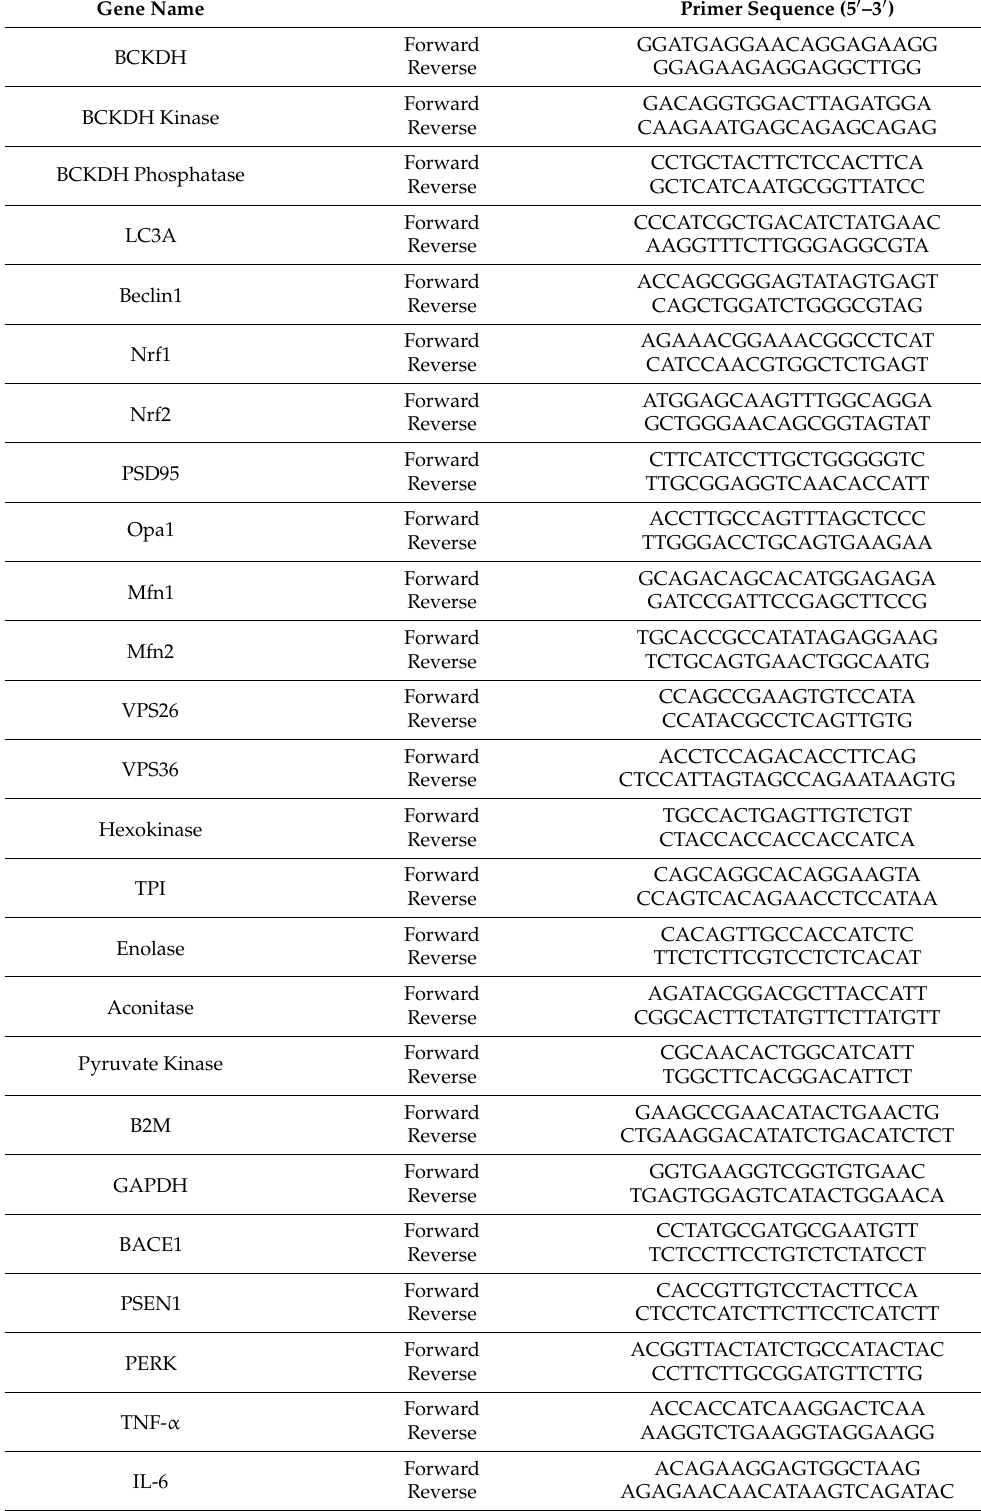
Table 2. Primer sequences for genes measured by